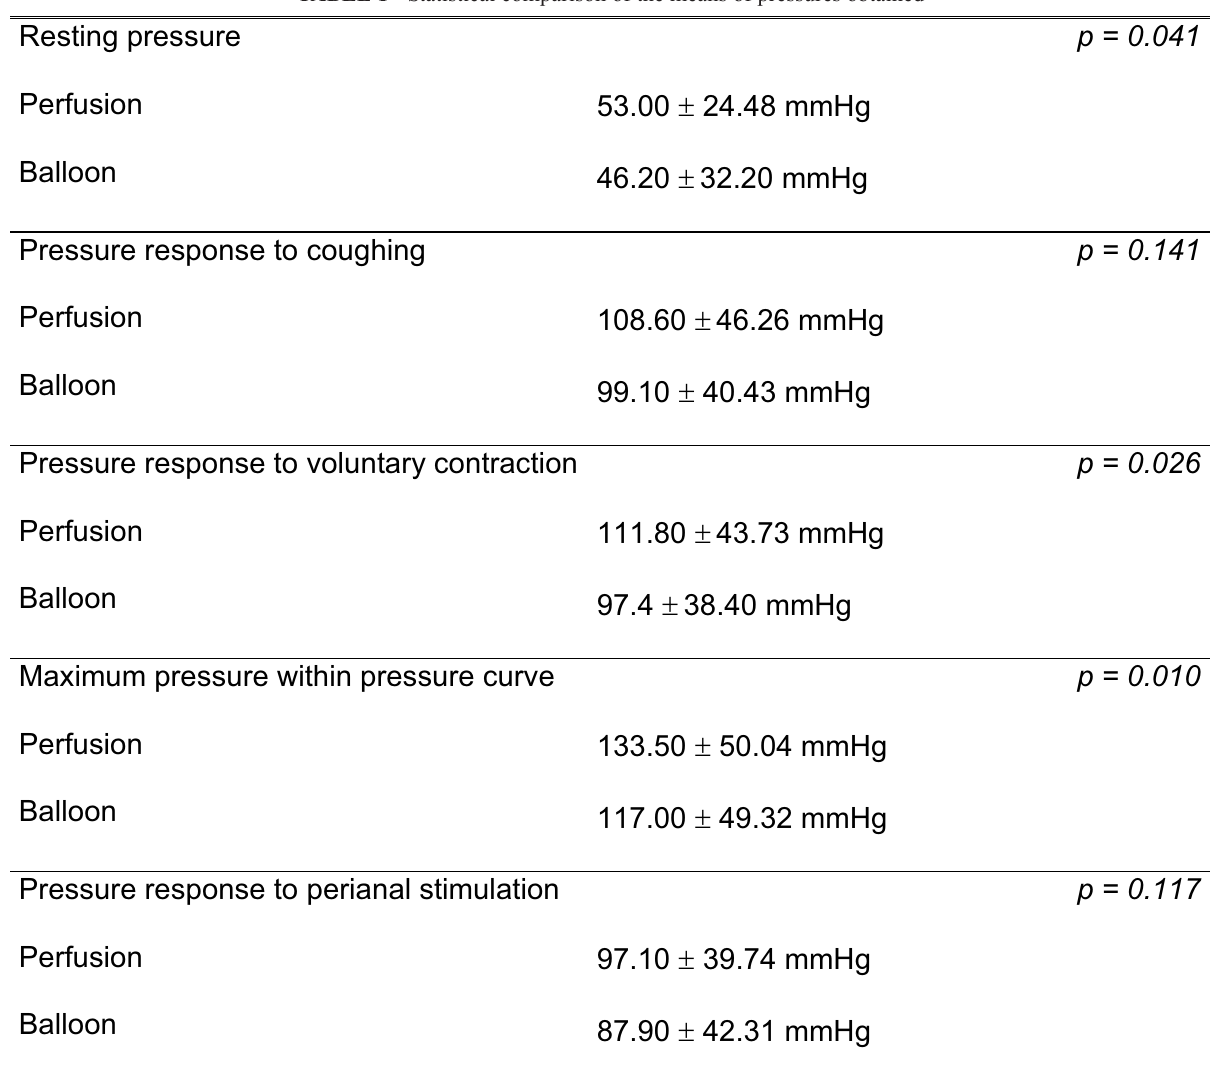
TABLE 1 - Statistical comparison of the means of pressures